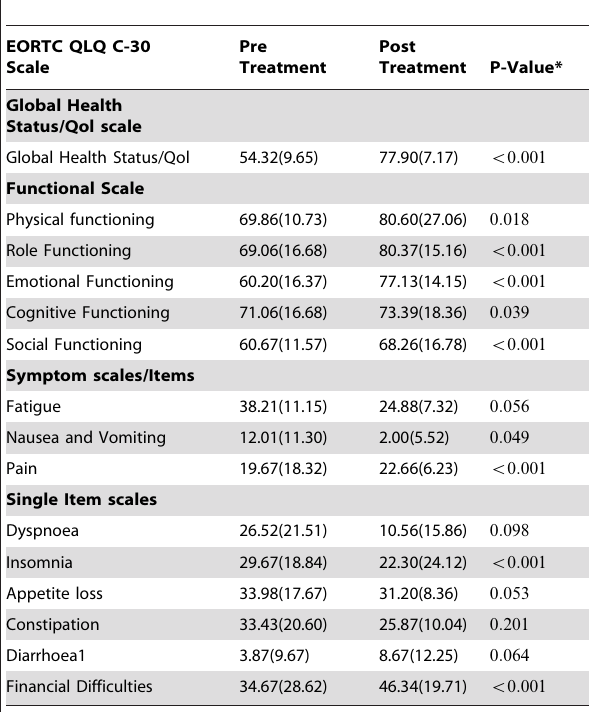
Table 3. EORTC QLQ CX-24 cervical cancer module scores in cervical cancer woman pre and post